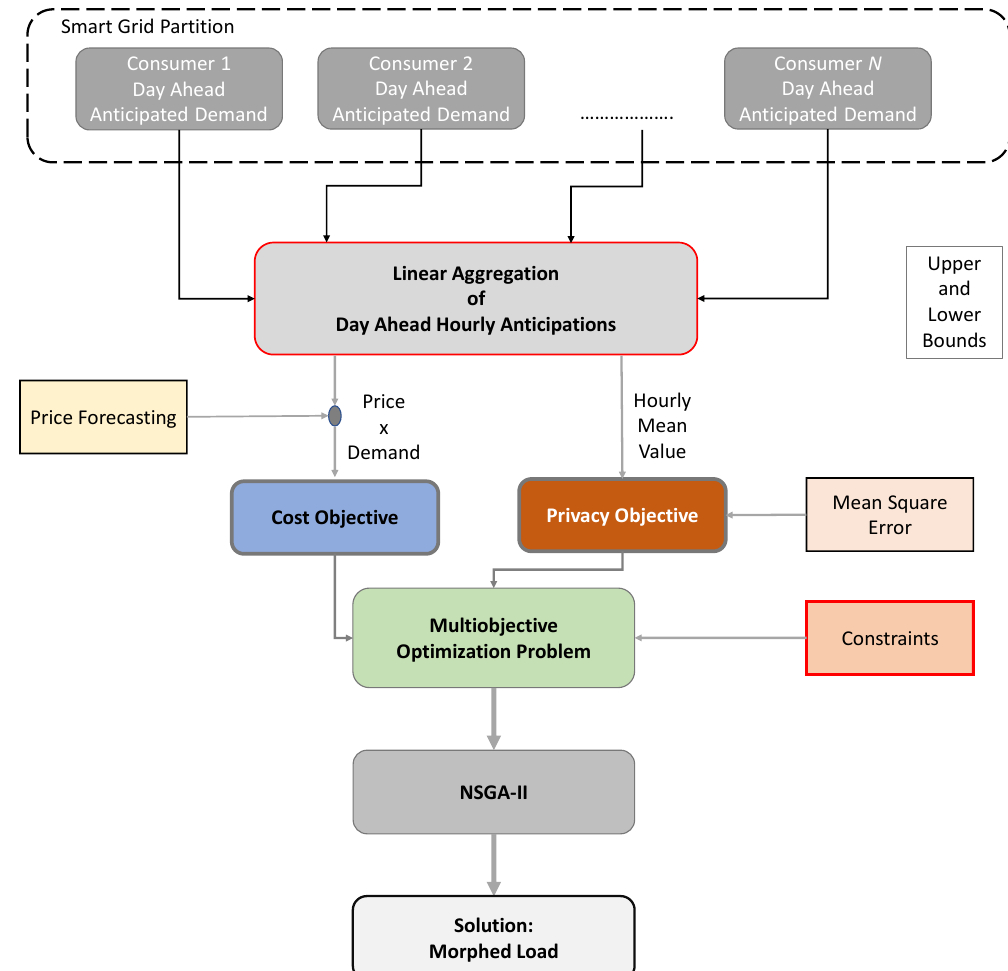
Figure 3. Block diagram of the grid partition load morphing methodology.